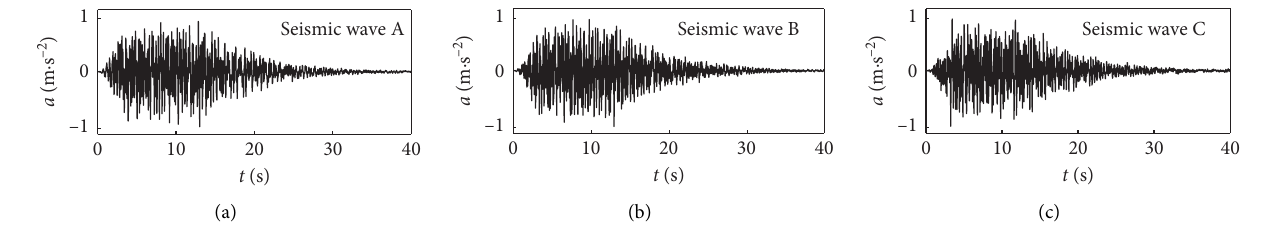
Figure 6: Time histories of the artificial seismic